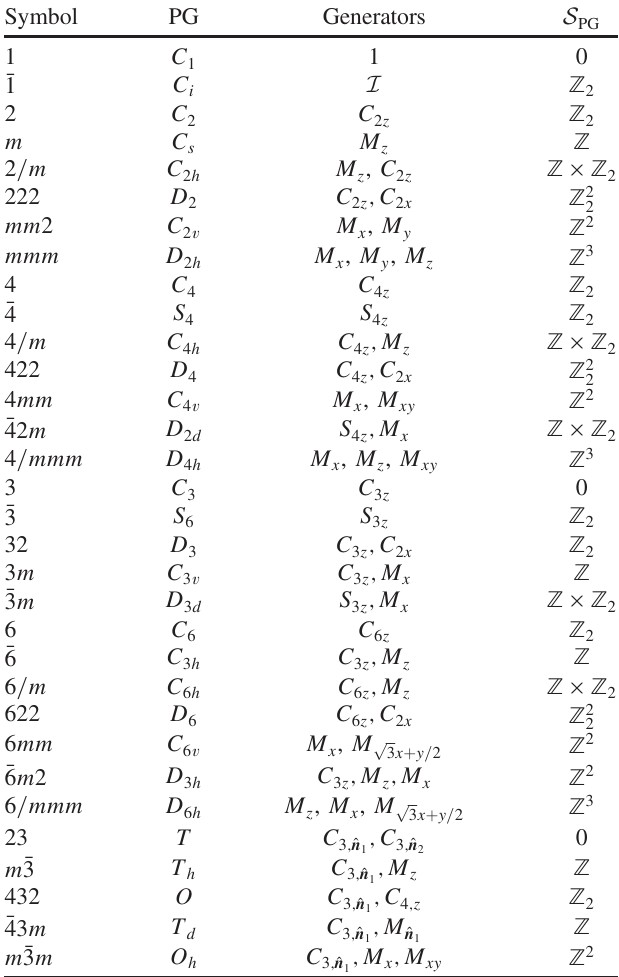
TABLE II. Classification of point-group sTCIs S classification of point-group sTCIs. The generators are chosen according to the criteria defined in the main text. Here, ˆ n 1 and ˆ n 2 denote two of the four threefold rotation axes in the cubic PGs. These describe systems with cubic symmetry with four threefold axes along the cube body